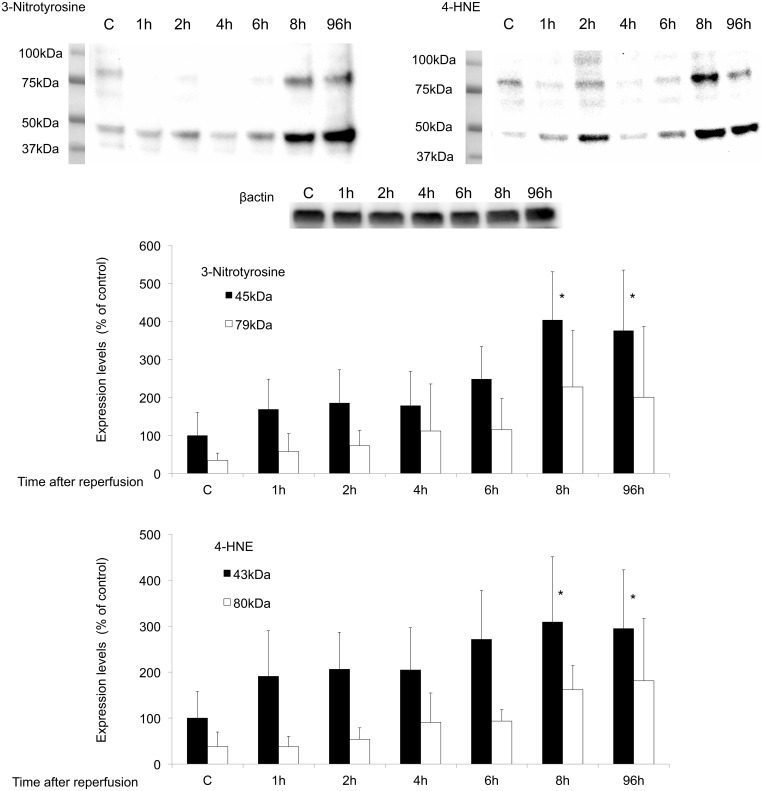
Time course of western blotting studies for monitoring protein nitration and lipid peroxidation.Solid bars represent 3-nitrotyrosine (45 kDa) and 4-HNE (43 kDa) values. Open bars represent 3-nitrotyrosine (79 kDa) and 4-HNE (80 kDa) values. The intensity levels are given as the mean ± SD normalized to the β-actin level for each sample (n = 7). Data were analyzed for significance using repeated-measures ANOVA with a Greenhouse-Geisser correction followed by post hoc tests using the Bonferroni correction. *p<0.05 vs. control. The entire images are shown in S1–S3 Figs.